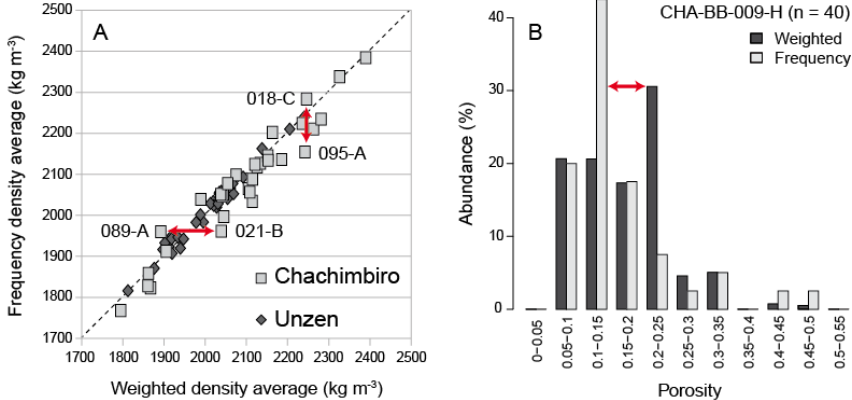
Figure 3. Comparison between frequency and weighted analyses. (a) Weighted vs. frequency density average for Chachimbiro and Unzen data sets, note the large relative differences highlighted by the red arrows (see Sect. 3.1 for explanation); (b) porosity abundance histogram for one sample from the Chachimbiro data set, note the large difference (10%) of the main porosity mode between the two statistical methods represented by the red arrow.